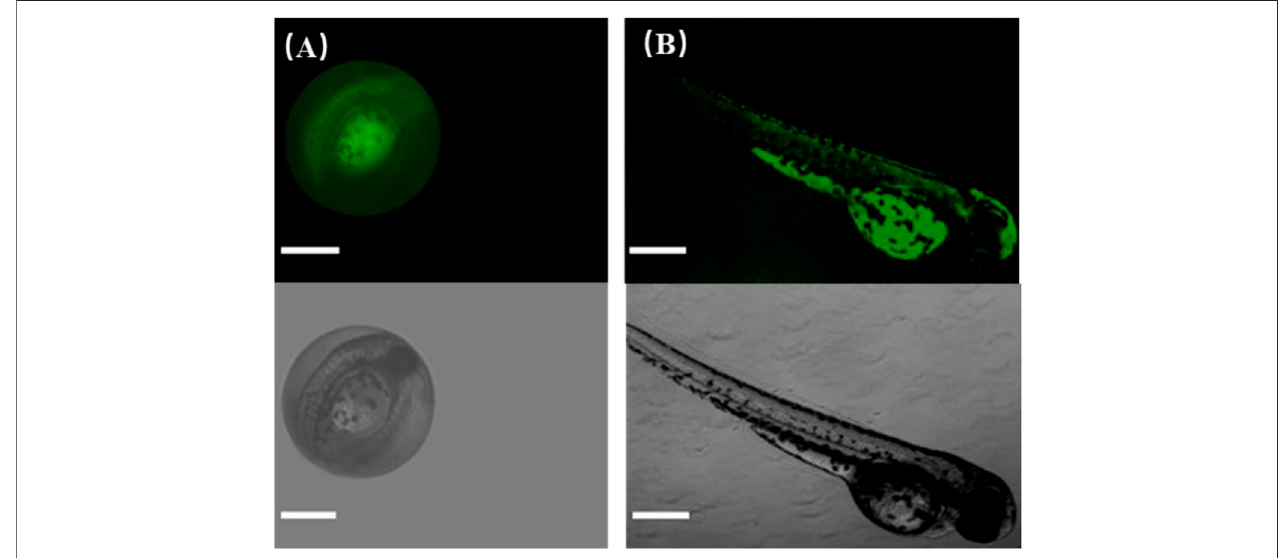
FIGURE 8 | Fluorescence images of CDs in living zebra fi sh grown for (A) 1 day old and (B) 5 days old. The scale bar is 500 μ m.